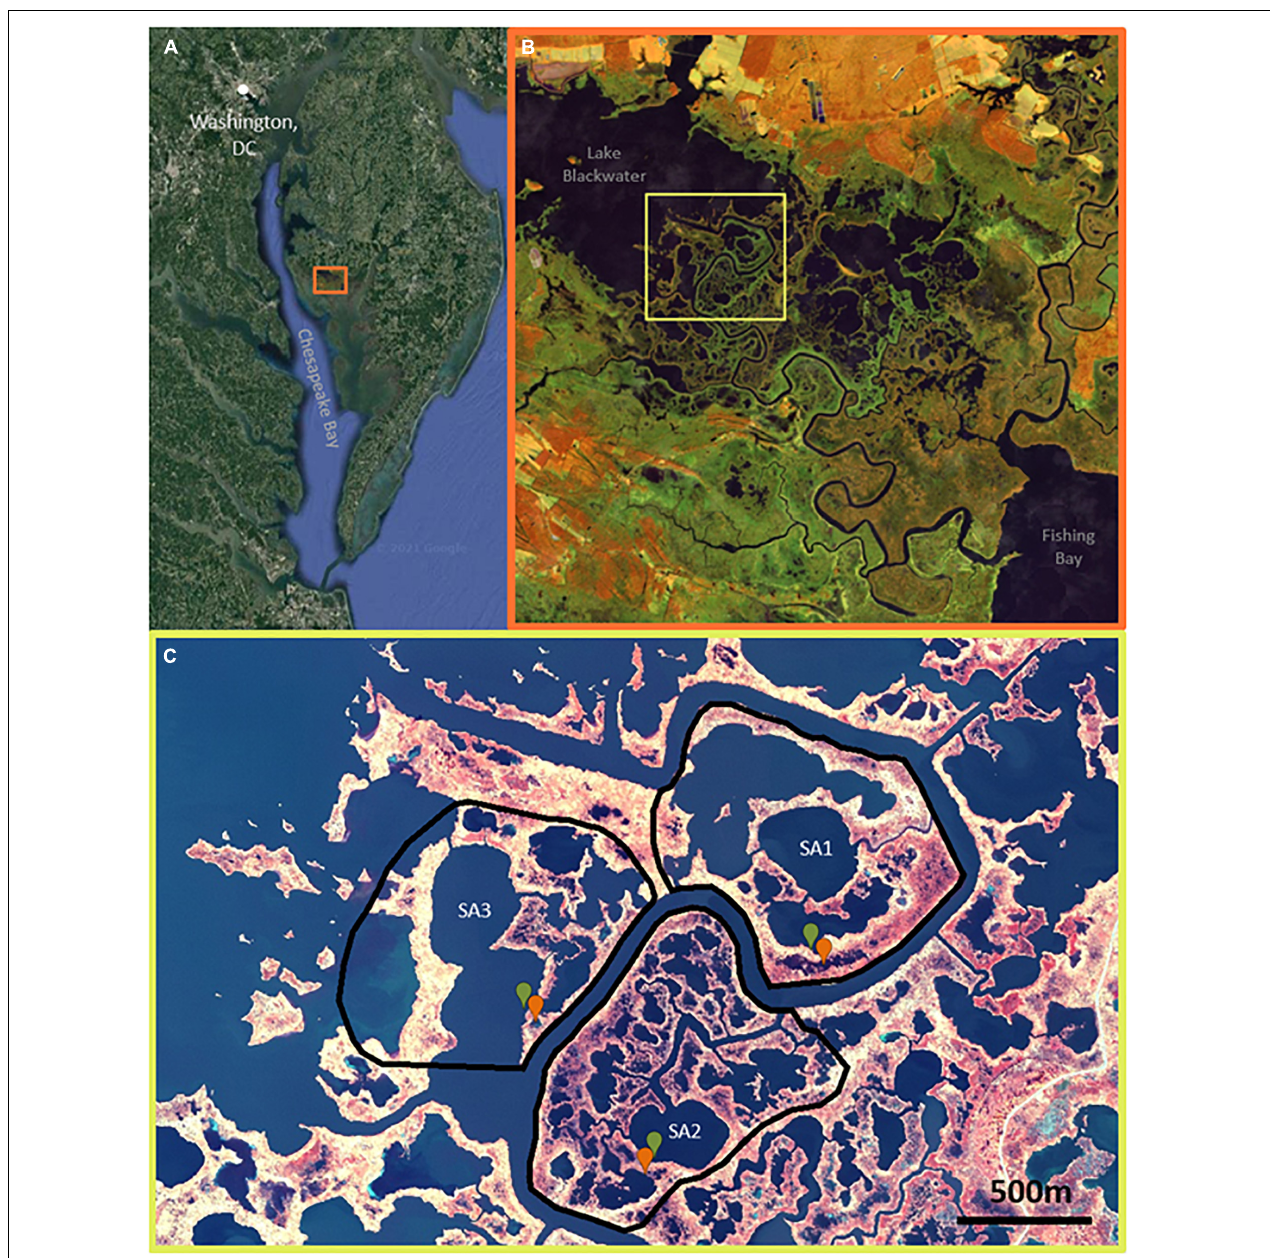
FIGURE 1 | (A) Location of Blackwater Wildlife Refuge (38.4220 ◦ N, 76.0624 ◦ W) outlined by orange square on the Eastern edge of Chesapeake Bay. (B) Overview of the 28,000-acre refuge, evidencing vegetation die-off and marsh loss following a gradient from low die-off near southeastern Fishing Bay to high die-off near Lake Blackwater at the northwest reaches of Blackwater River; false-color (NIR, SWIR, R) Sentinel-2 imagery 2020-11. (C) The three study areas used for remote sensing analyses with the field-sampled ponds (green is stable, red is unstable) indicated within; false-color (NIR, G, B) NAIP